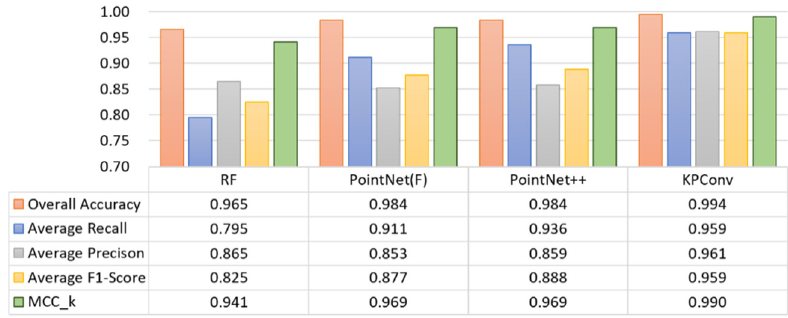
Figure 13. Comparison of classification results on MLS point clouds using RF and three deep learning models.